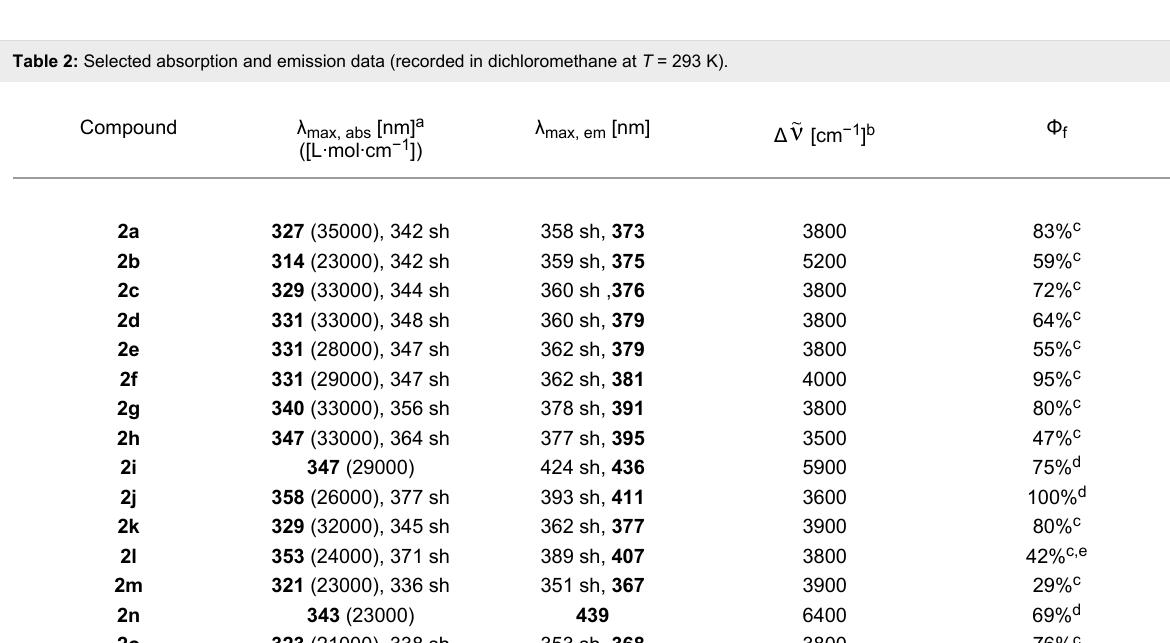
The most furans display intense, broad absorption bands between 321 and 358 nm with molar extinction coefficients between 21000 to 35000 L/mol cm − 1 . In addition redshifted shoulders appear between 336 and 377 nm. Likewise the emis- sion maxima are found between 367 and 439 nm and blueshifted shoulders appear between 351 and 424 nm. The Stokes shifts determined from the absorption and